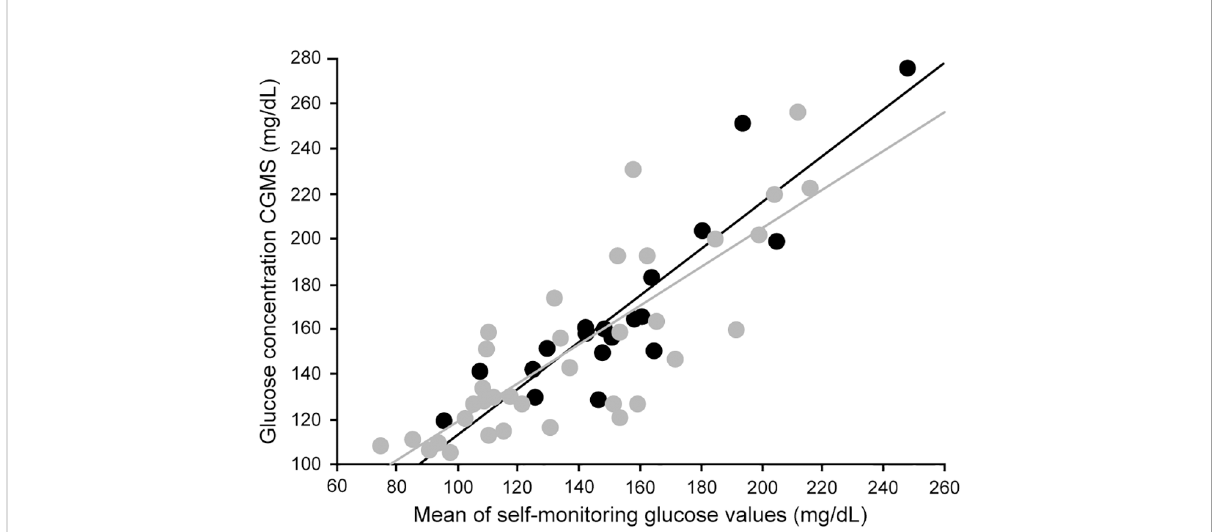
FIGURE 5 Correlation between mean glucose levels obtained through glucose meters and CGM in hemodialysis type 2 diabetes (dark circles) and nondialysis type 2 diabetes (light circles) (Ref (94).). Correlation in the entire patient group (r = 0.84; P<0.00001). Correlation in hemodialysis type 2 patients (dark line) (r = 0.90; P<0.0001). Correlation in nondialysis type 2 patients (light line) (r = 0.81;